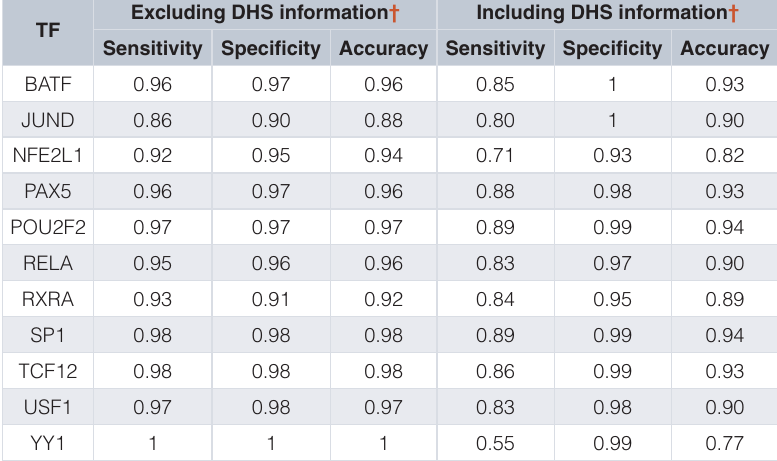
Table 3. The Decision Tree classifier performance for predicting TF targets using the siRNA-generated knockdown data.